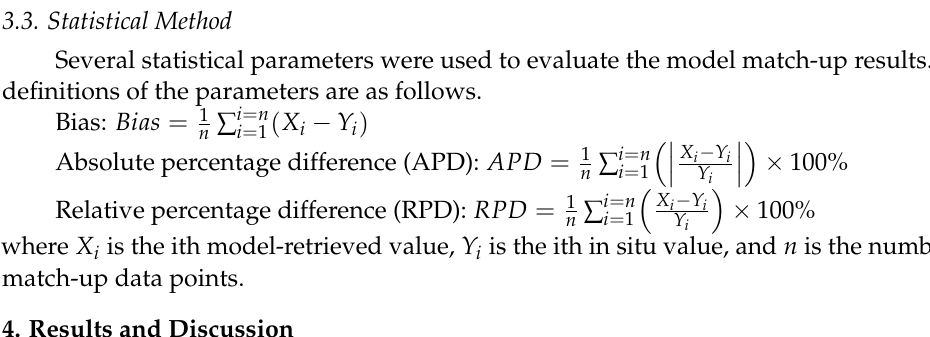
Figure 2. Station of the South China Sea.